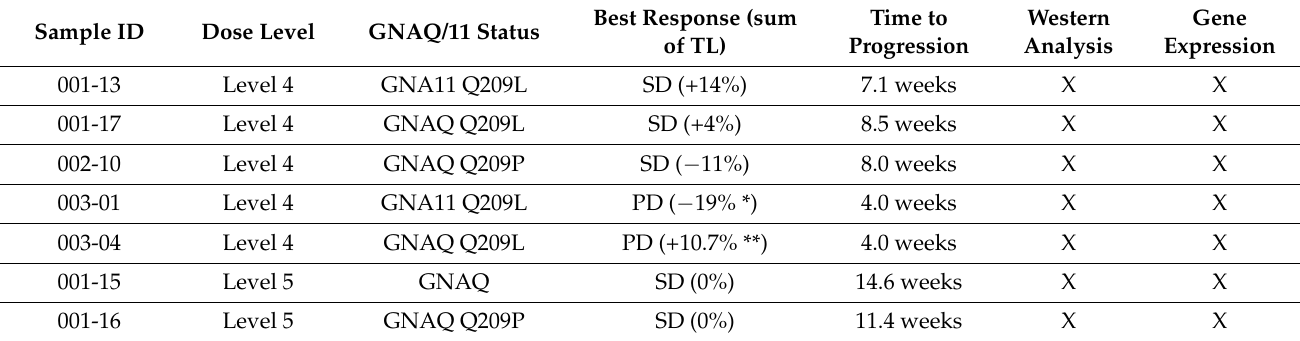
Table A4. Clinical summary of patients with samples analyzed for PD, gene expression, and mIHC.